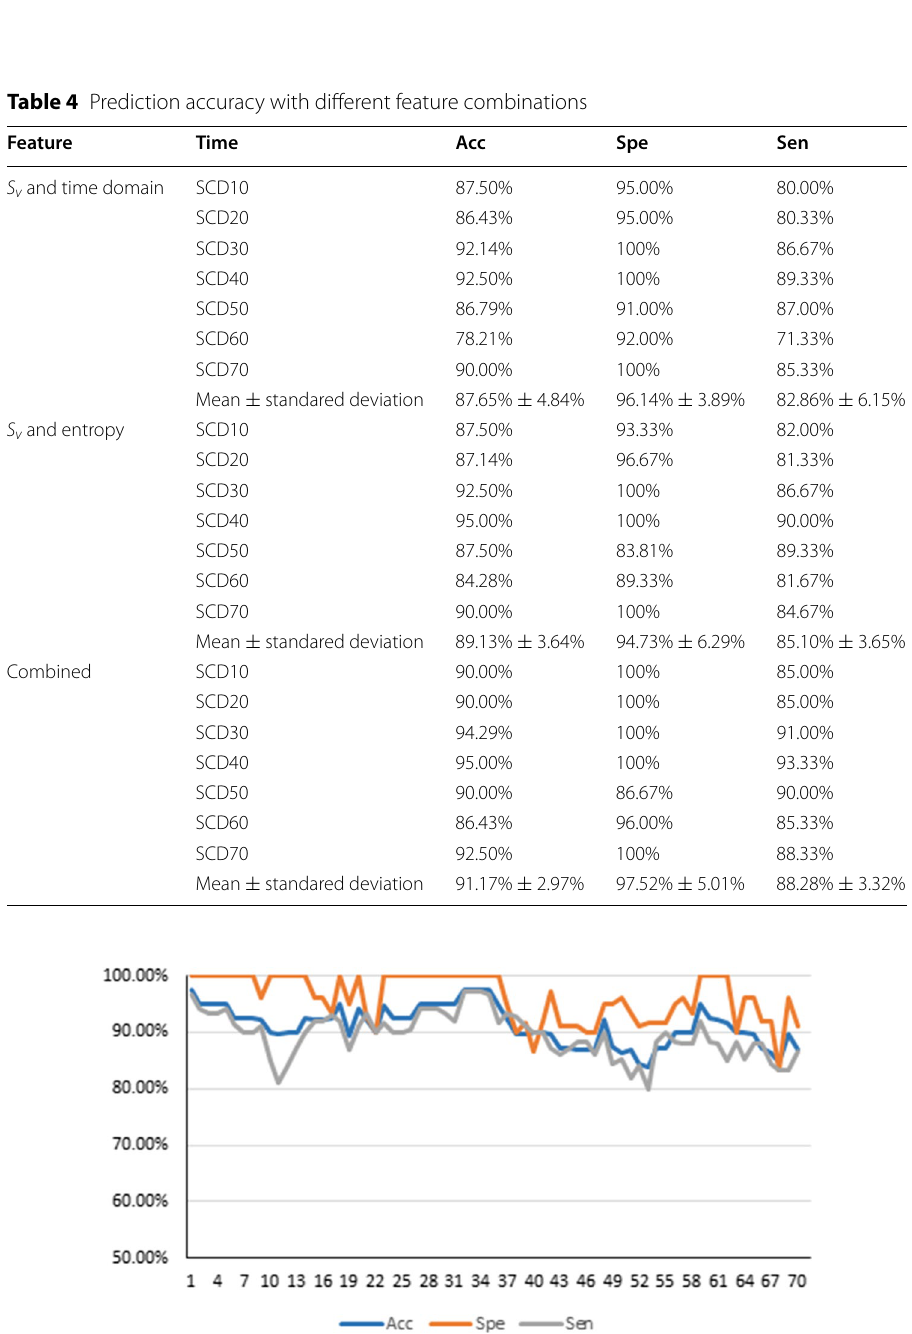
Fig. 7 Classification result of SCD in each minute using the combined